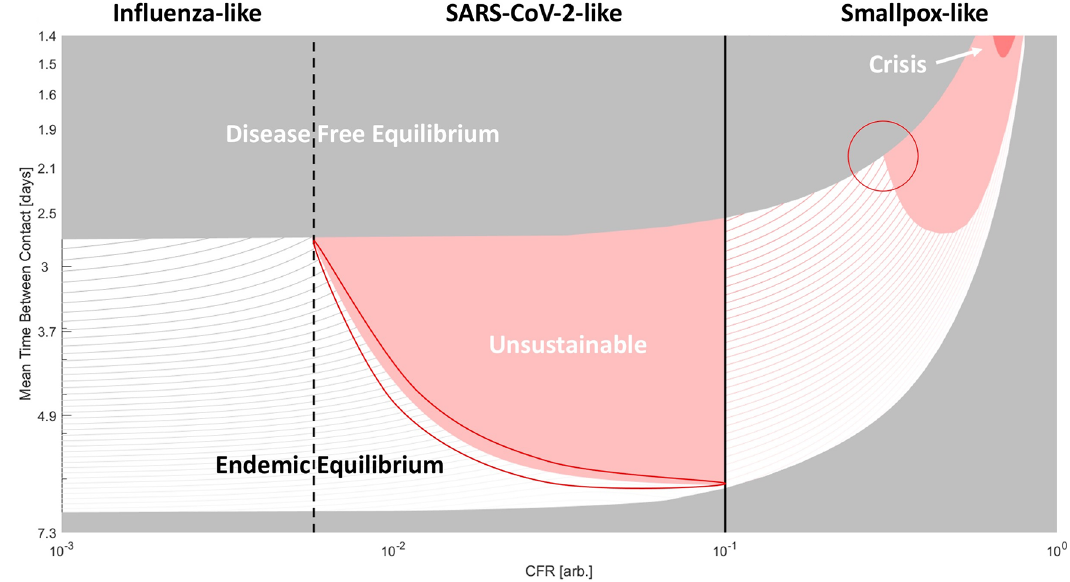
Figure 3. Phase diagram of epidemiological outcomes. The CFR and the contact rate were varied. For variable recovery rate, see Figure S1. Disease-free equilibrium (gray), endemic equilibrium (striped), unsustainable (red), and host population crisis (loss of 90%, dark red) regions are shown. For CFR > 10%, smallpox-like features are assumed. For CFR<10% SARS-CoV-2/influenza-like features are assumed (these viruses are only distinguished within the model by CFR). Lines within the region bounding endemic equilibrium indicate contours for the percentage of the population infected ( a * + c * )*100. Darker color corresponds to higher values. Two regions subject to kinetic constraints are